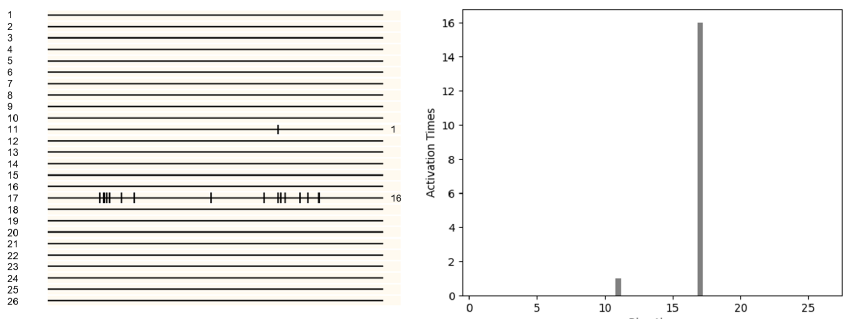
Figure 11. The neuron activation diagram in the twenty-six direction caused by the motion of the 16-voxel random-dot object in the three dimensional space ( left ). Each line represents 26 directions, each point on the line represents the detection neuron, and each stimulation on the line represents that the neuron at this point is activated. The number of activations represented by a histogram ( right ). The number of activations of neurons in all directions is displayed on the histogram. The 5th- direction neurons have the highest number of activations. It can be referred that the object moves in the 5th direction.